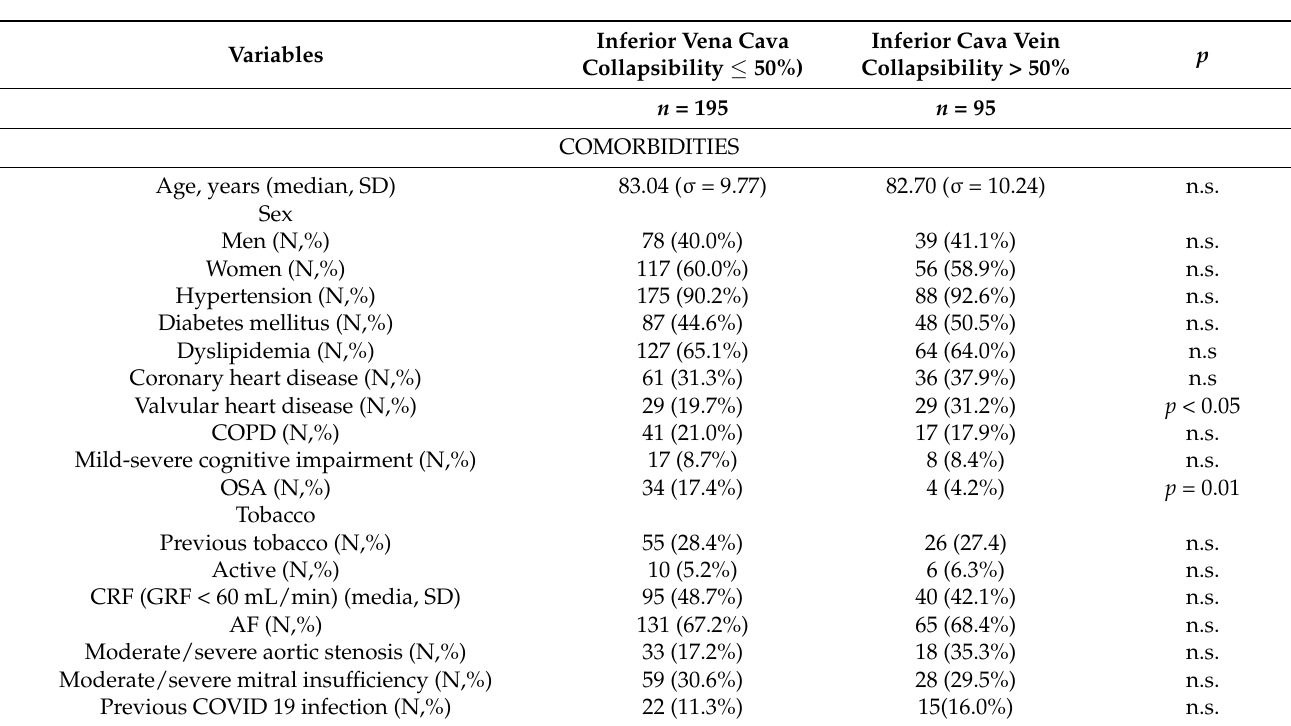
Table 2. Baseline characteristics of patients with heart failure according to inferior vena cava collapsi- bility (>50% or ≤